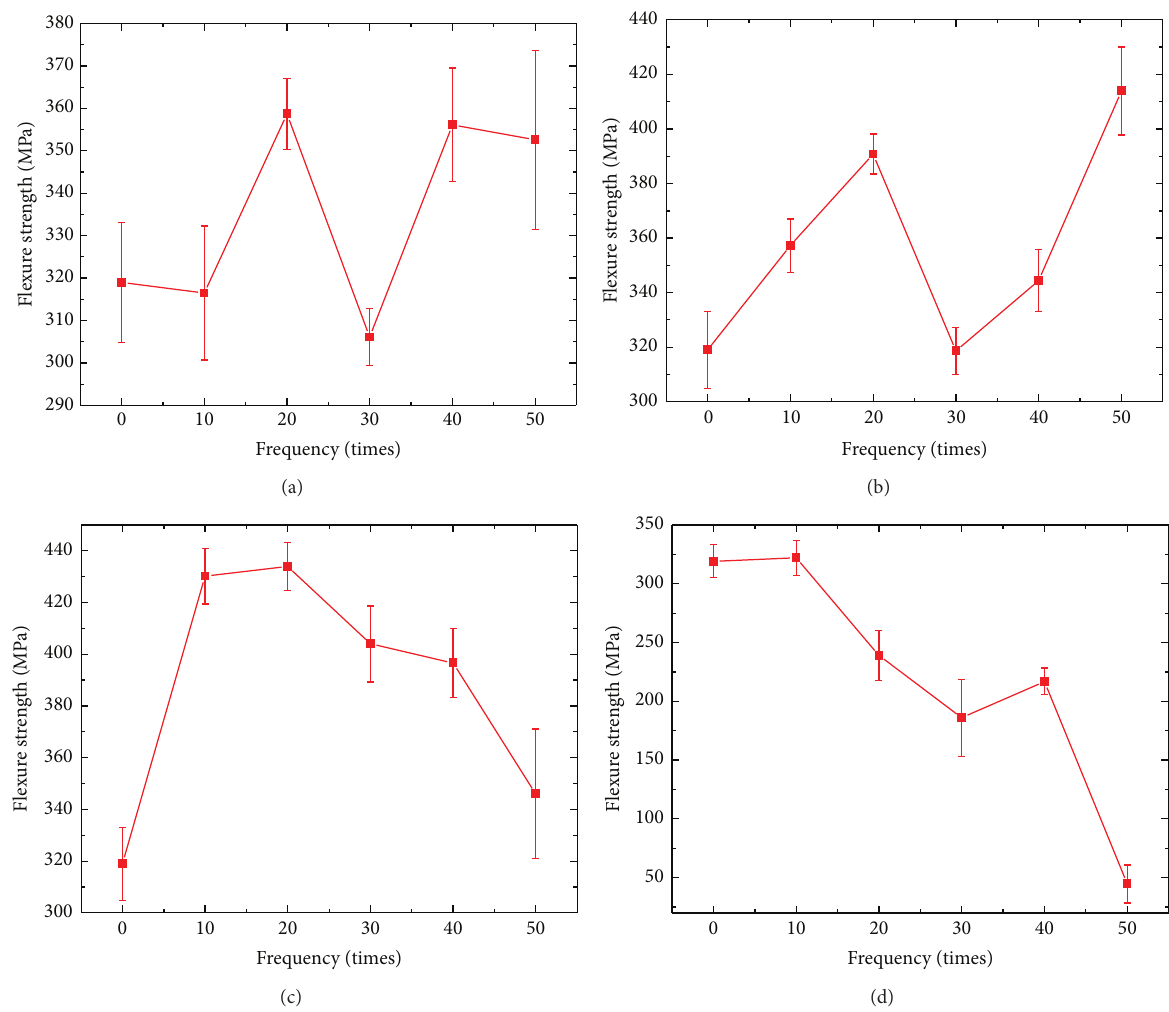
Figure 4: Residual strengths of ZSB materials after thermal shock for different times: (a) 1200 ∘ C; (b) 1400 ∘ C; (c) 1600 ∘ C; (d) 1800 ∘